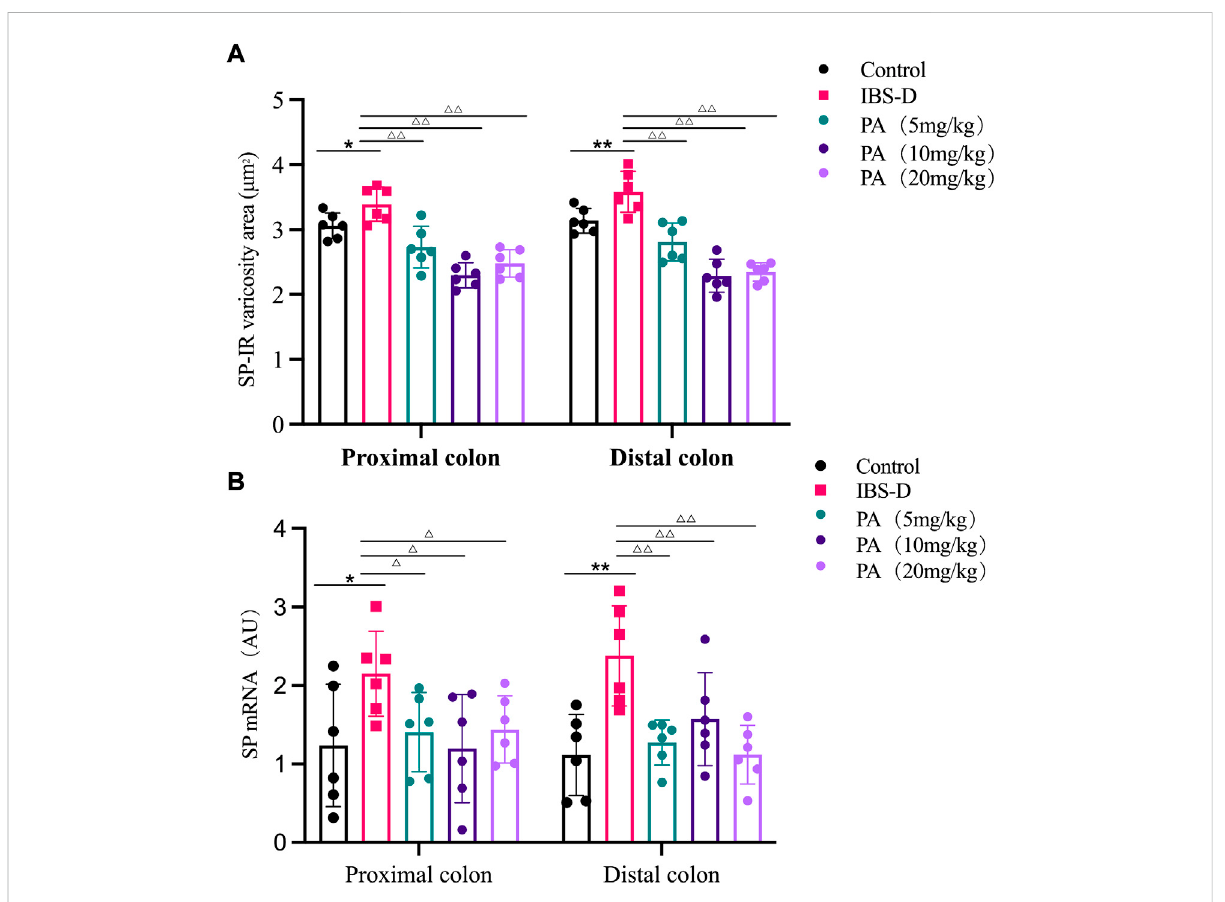
FIGURE 6 (A) SP-immunoreactive varicosities in the distal and proximal colon of PA groups. (B) SP mRNA expression in PA groups. RNA was isolated with TRIzol reagent and qRT-PCR was utilized to analyze the gene expression of SP. The GAPDH gene was used